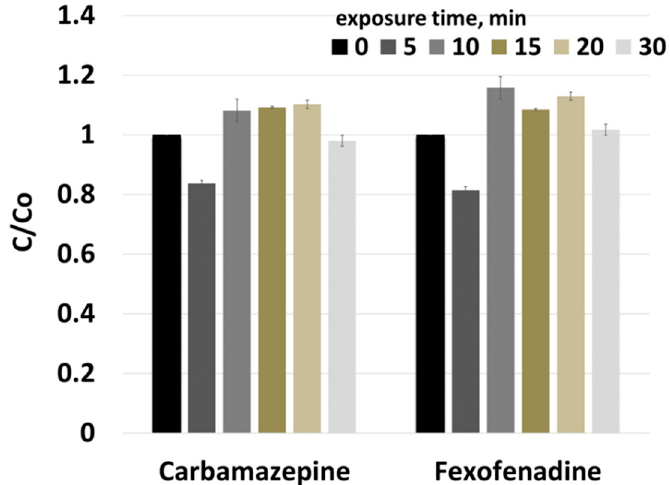
Figure 2. Results of kinetic experiments showing removal of the organic micropollutants carbamazepine and fexofenadine by granulated activated carbon (GAC) in a full-scale drinking water treatment process (Ref-N6). Table 1. Compound name, molecular formula, molar mass, acid dissociation constant (pK a ), log octanol/water partition coefficient (K ow ) and T 1/2 (half-life time, min) of concentration in the aqueous phase, and Freundlich adsorption coefficient (Kf) for the seven selected organic micropollutants (OMPs) onto two different granulated active carbon (GAC) types (Norit 830W and Filtrasorb 400).